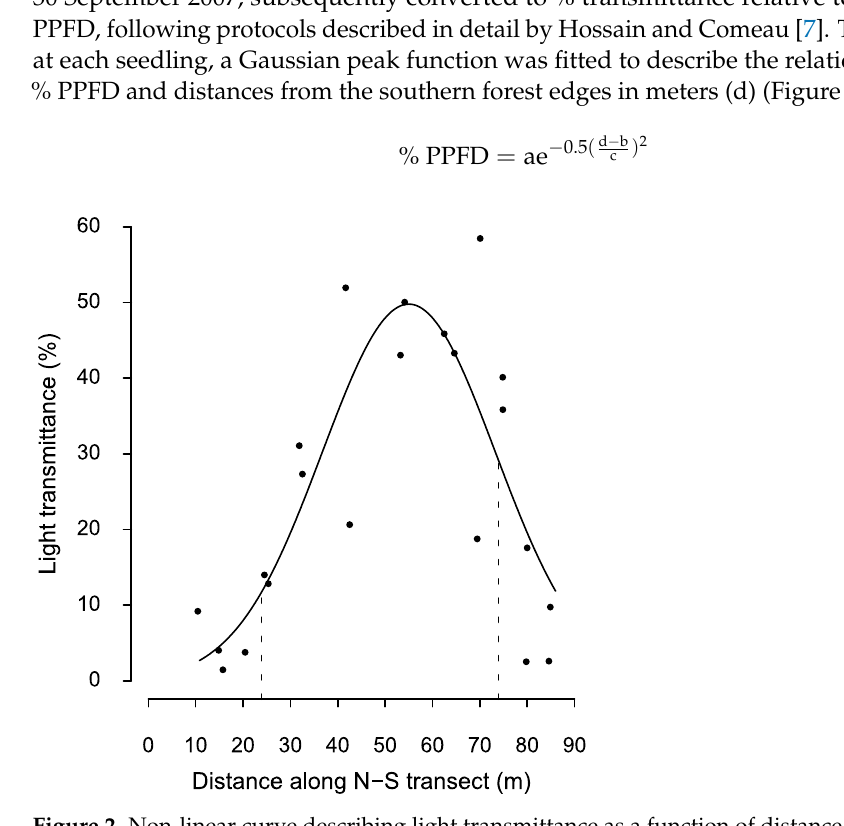
Figure 2. Non-linear curve describing light transmittance as a function of distance from the furthest point under the south canopy. Here, N = 22, rmse (root mean square error) = 10.89, Pseudo R 2 = 0.69. All parameters (a = 49.78, b = 55.02, c = 18.29) are highly significant ( p < 0.001). Black dashed line indicates forest edges.